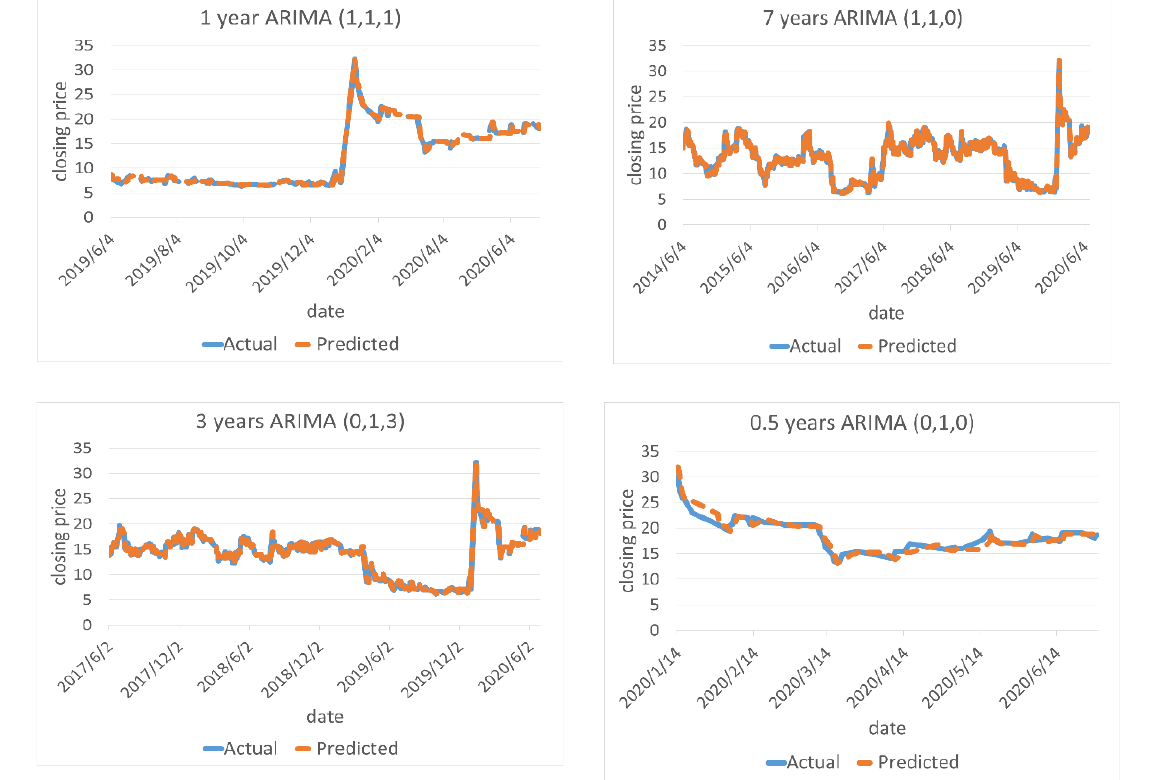
Figure 2. Prediction diagram of the optimal ARIMA models for 7, 3, 1, and 0.5 years for 3083 Chi- neseGamer.